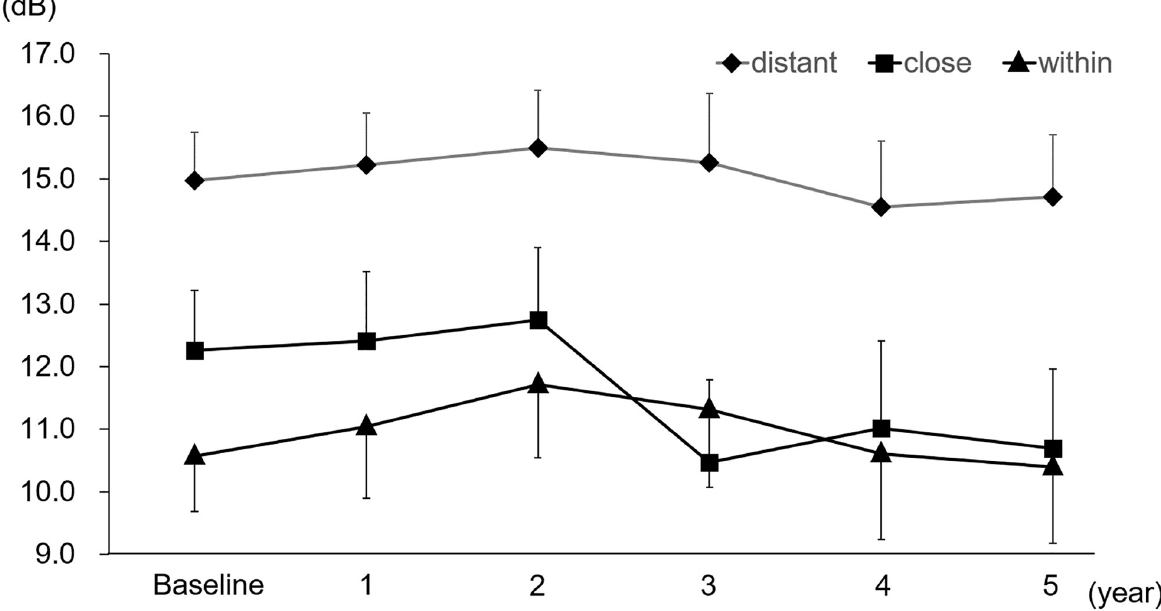
Fig 3. The association between the mean retinal sensitivity and the distance from the abnormal FAF (1,215 points per year). Total 1,215 points were classified as “Within” (within abnormal FAF), “Close” (within 1 degree from the border of abnormal FAF), and “Distant” (over 1 degree from the border of abnormal FAF). Data are expressed as mean ±